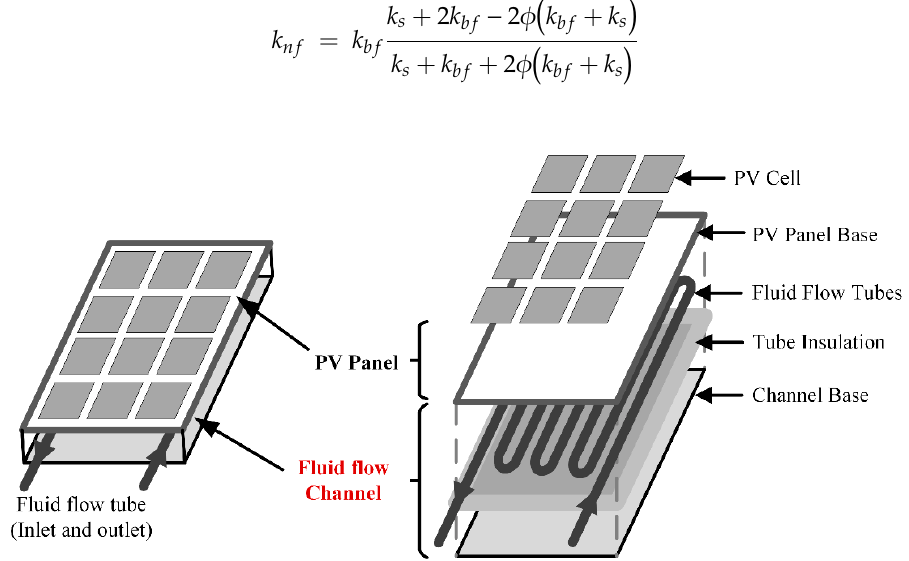
Figure 3. Schematic diagram of the proposed nanofluid backflow channel-based PV panel.